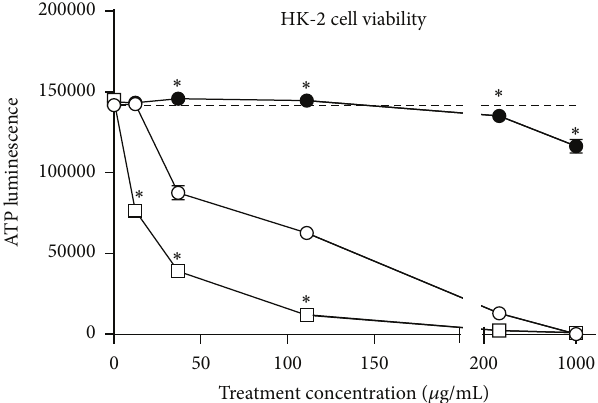
dose-dependent manner. HK-2 cells were treated with C. zacate- chichi (open circles), cisplatin (open squares), or valproic acid (filled circles) at mean average concentrations ( ± SEM) ranging from 0 to 1000 𝜇 g/mL and cell viability was quantitatively assayed by ATP luminescence 24 hours after treatment. Dashed line indicates “no treatment” baseline ATP levels. ∗ , cisplatin or valproic acid versus C. zacatechichi , 𝑃 < 0.001